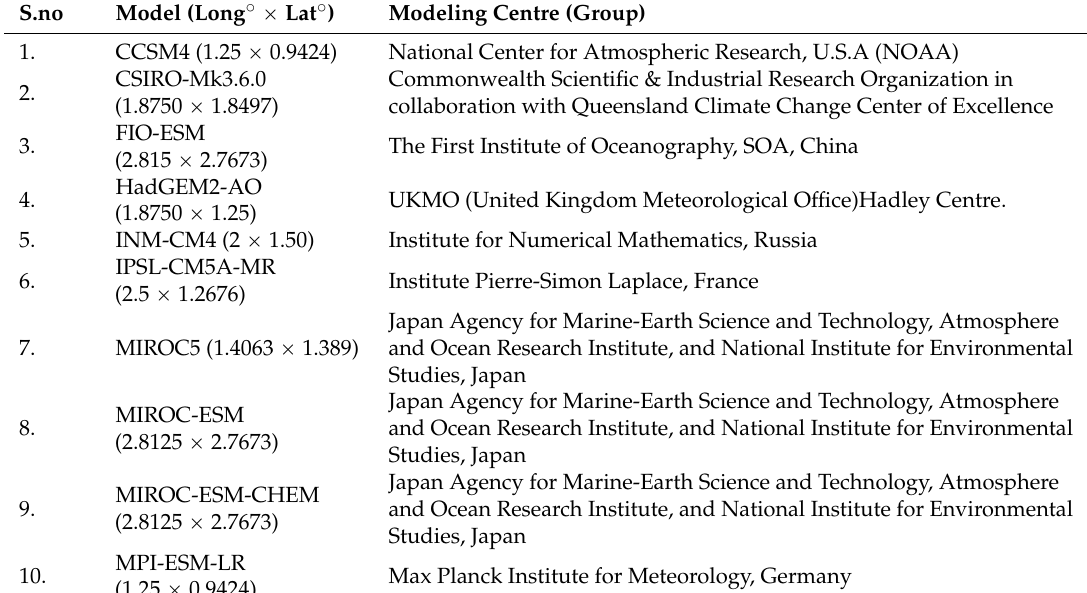
Table 1. Details of the coupled model inter-comparison project 5 (CMIP5) models considered for the